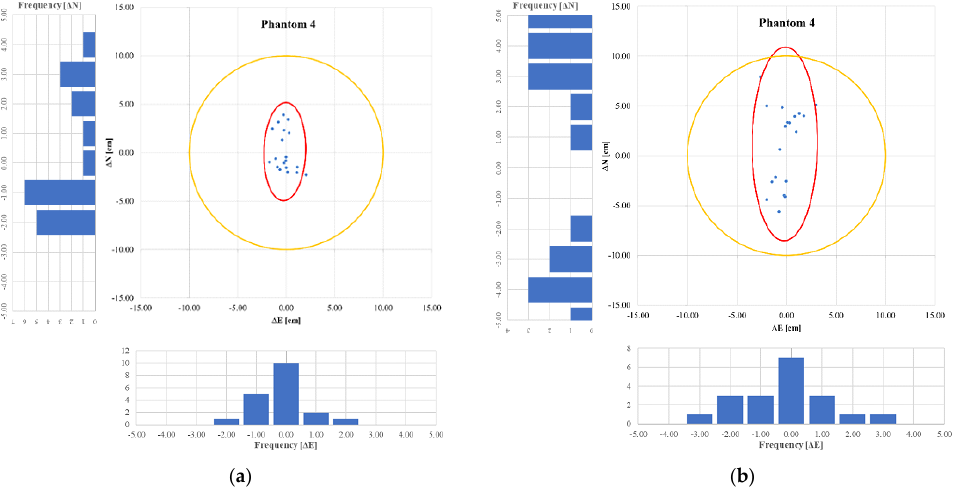
Figure 6. Confidence ellipse — Phantom 4 with GCPs at 60 m ( a ); Confidence ellipse — Phantom 4 with GCPs at 120 m ( b ).